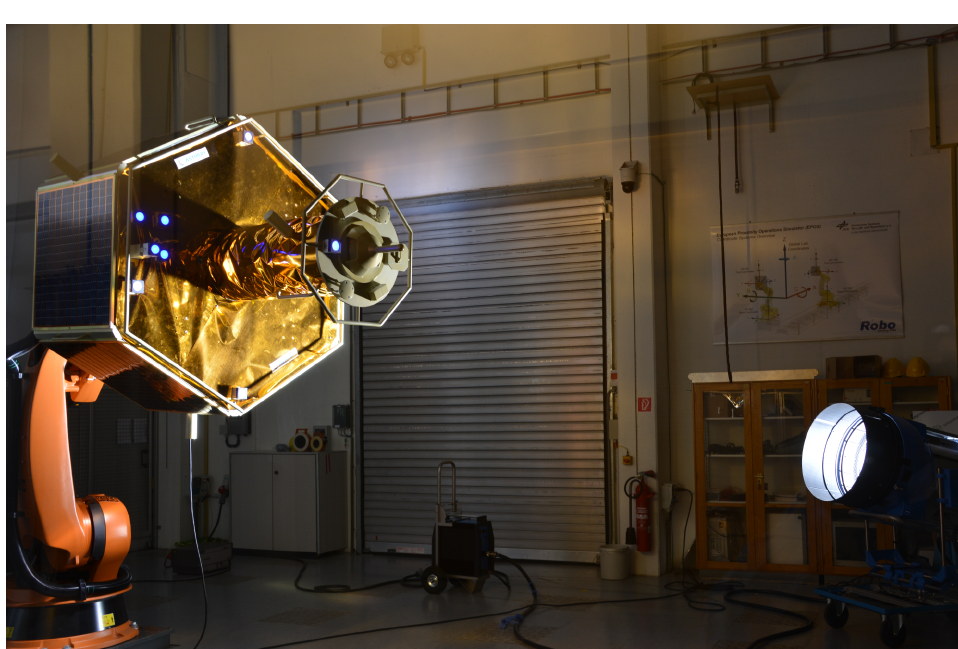
Figure 11. DEOS target mock up with golden